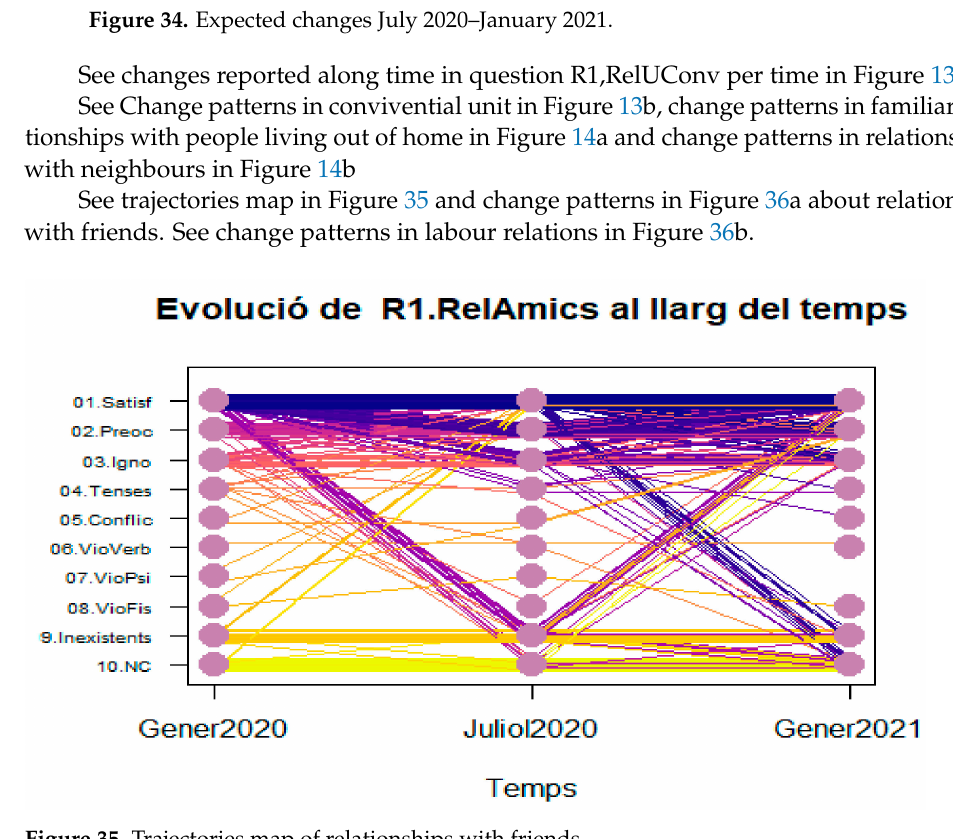
Figure 35. Trajectories map of relationships with friends.